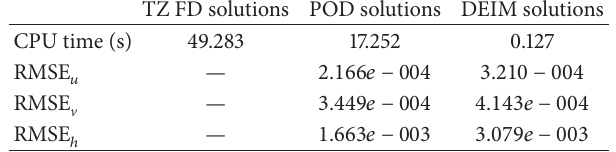
Table 2: CPU time gains and the root mean square errors for each of the model variables at 𝑡 = 24 h. The POD bases dimensions were 28 capturing more than 99.9% of the system energy. 60 DEIM points were